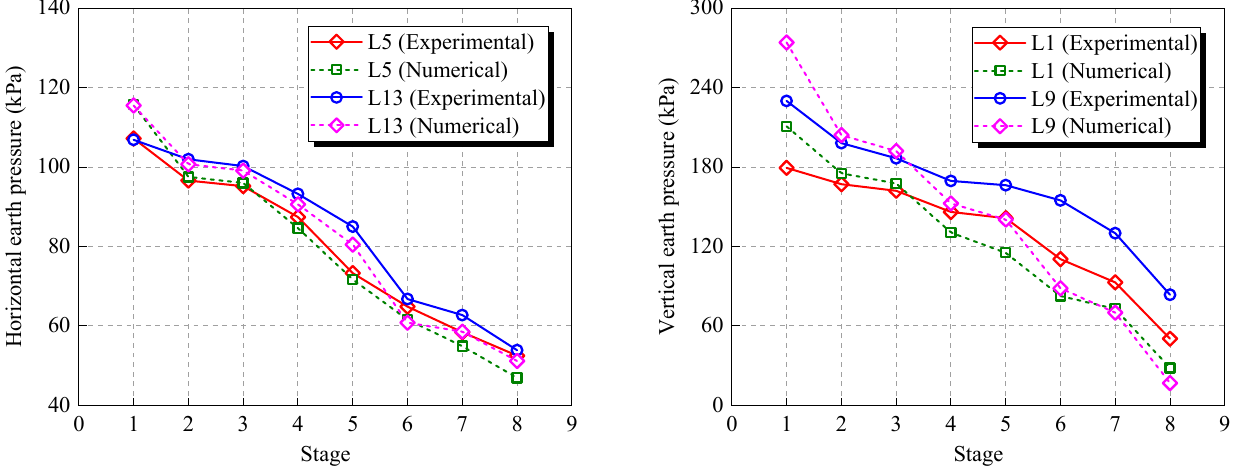
Figure 15. Comparison of earth pressure between numerical simulation and experimental test.